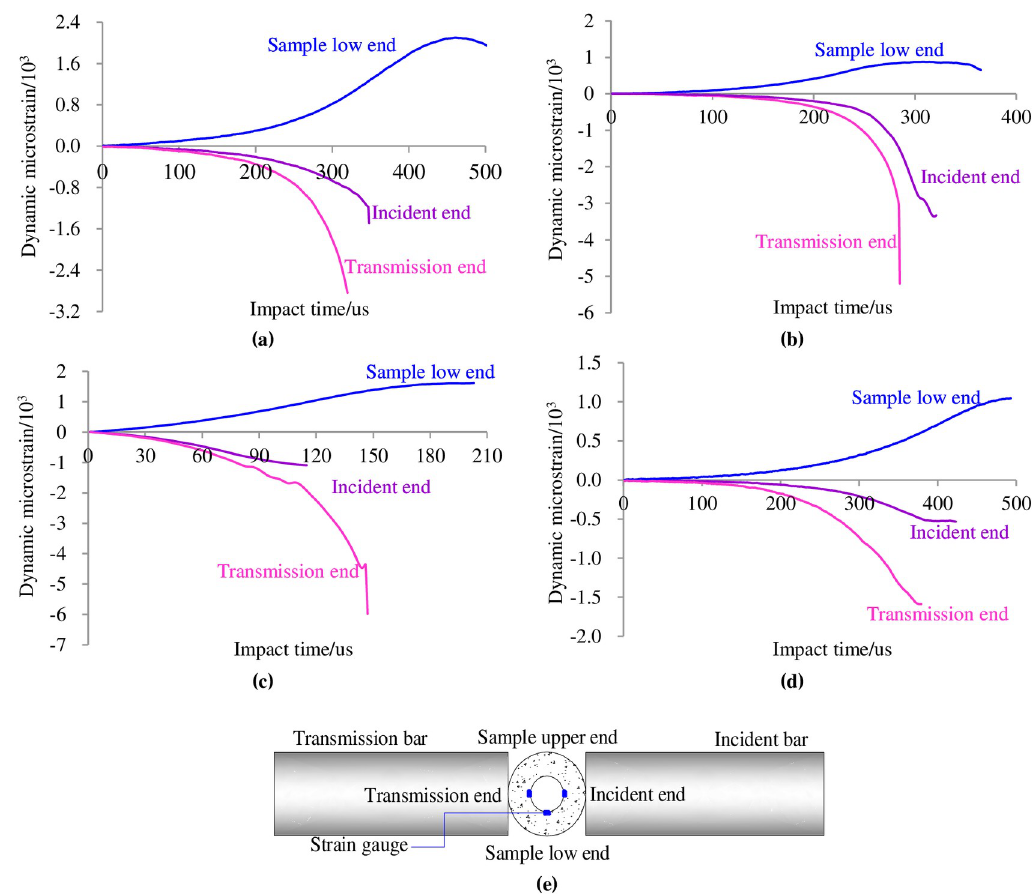
Fig 6. Changes in the ring wall dynamic strain at the incident end, transmission end and lower end of circular granite with loading time. (a) Sample GD1-3. (b) Sample GD2-2. (c) Sample GD3-2. (d) Sample GD4-5. (e) Schematic diagram of position marking of rock